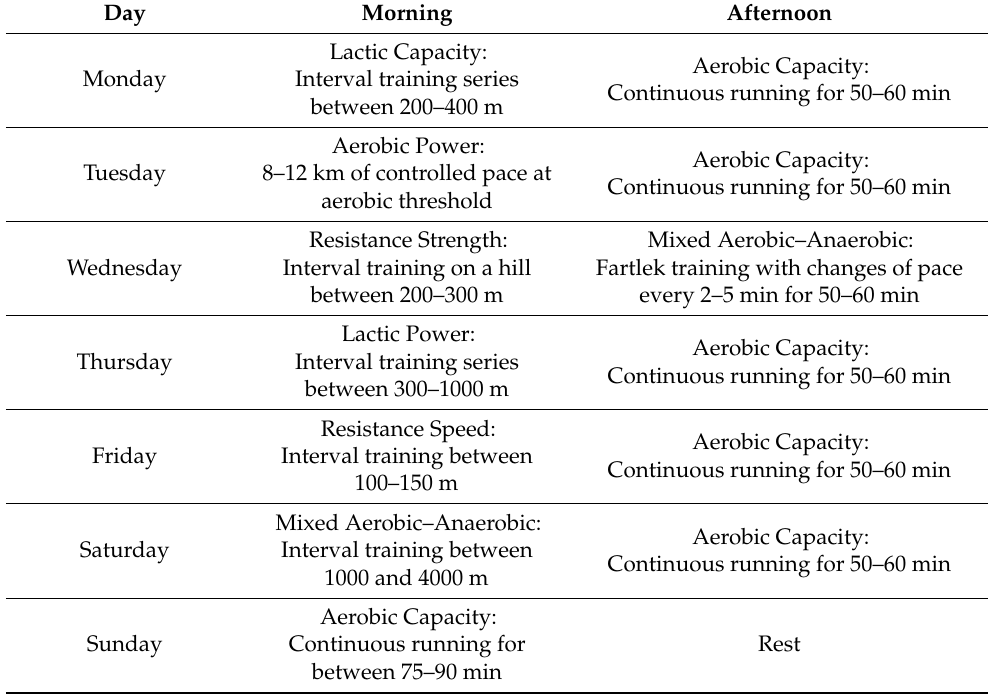
Table 2. The main contents of the typical weekly training program that was followed by both groups during the 8 weeks of the